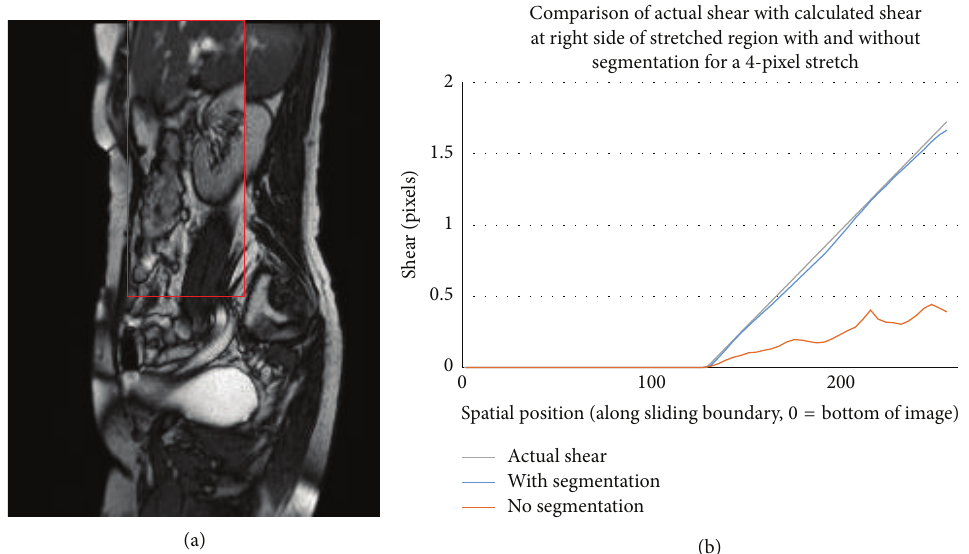
Figure 4: Validation experiment 1 with an idealised stretch of the portion of a MR image shown in (a) and shear results compared to actual shear in the system in (b).